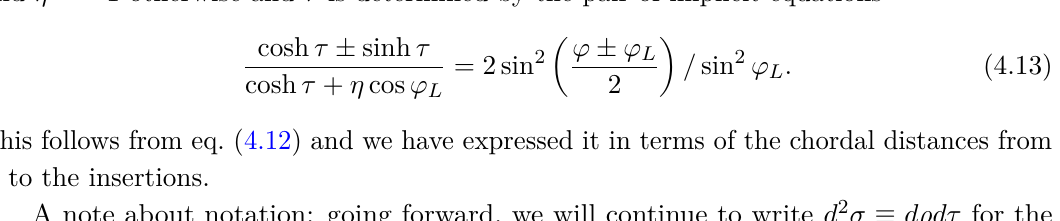
+ x 2 = 1 with Z J and ¯ Z J 1 2